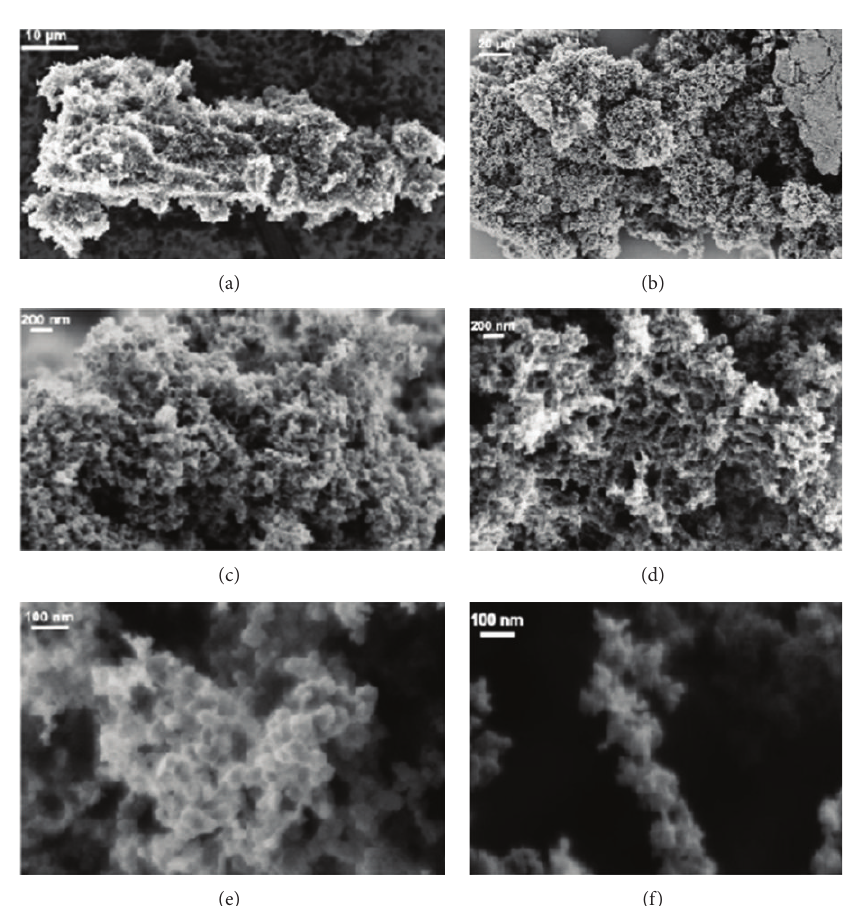
Figure 9: TEM images of the samples formed on the top (left side) and on the bottom of the quartz tube